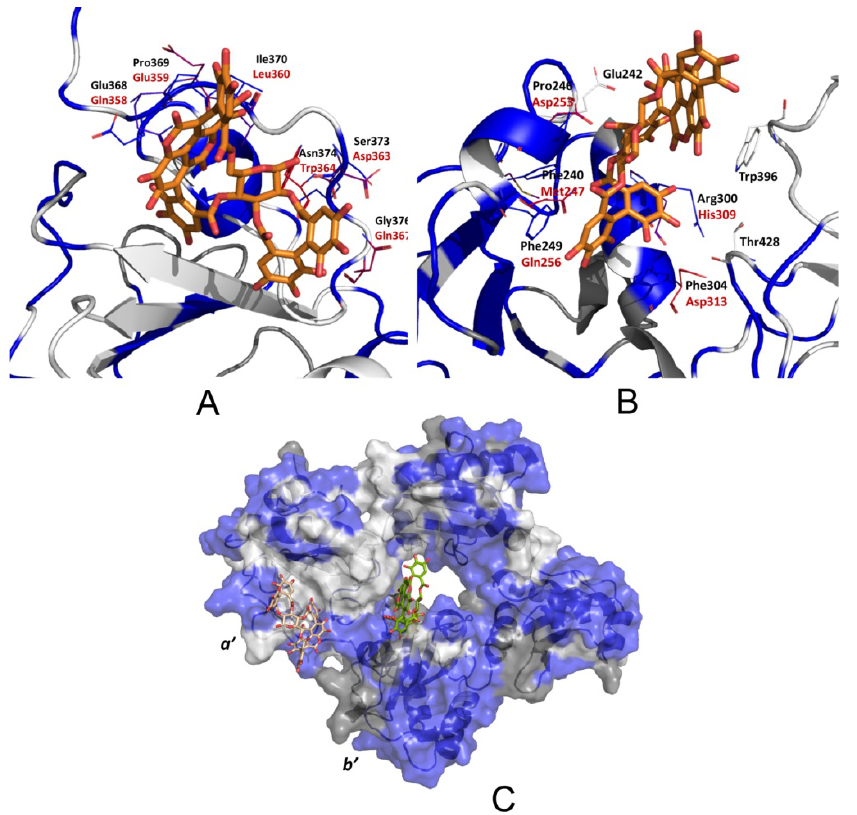
Figure 9. Comparative analysis of predicted β -punicalagin binding modes on PDIA3 and PDIA1. Residues are colored by conservation: white indicates conserved regions, blue nonconserved re- gions, and dark gray not aligned regions. ( A ) Predicted β -punicalagin binding mode on PDIA3 a’ domain. Nonconserved residue names are reported in black for PDIA3 and red for PDIA1. PDIA1 nonconserved residues are depicted as lines and colored from blue to red according to their score in the alignment matrix. ( B ) Predicted β -punicalagin binding mode on PDIA1 a’/b’ domains interface. Nonconserved residue names are reported in black for PDIA1 and in red for PDIA3. ( C ) Predicted β -punicalagin binding modes for PDIA3 (wheat) and PDIA1 (green) reported on the same structure (PDIA1) for comparison. Only a’ and b’ domains are visible.